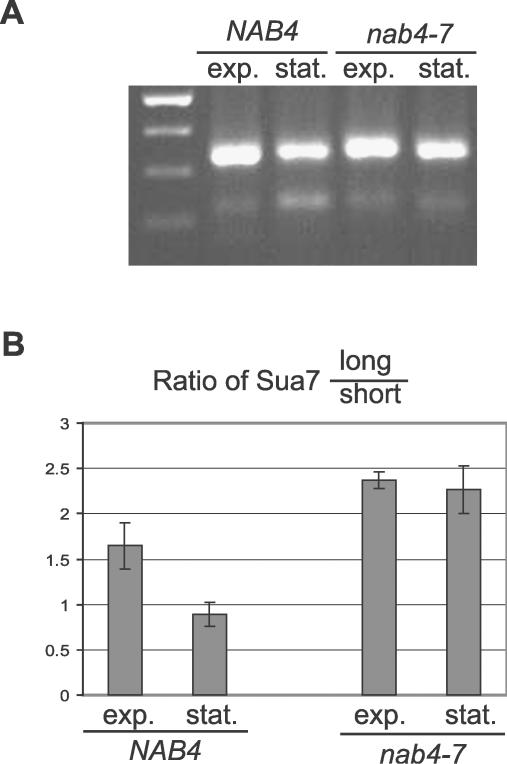

nab4-7 Displays Aberrant 3′ Cleavage Patterns for the SUA7 Transcript(A) 3′ RACE analysis of total RNA from NAB4 and nab4-7 strains in exponential and stationary phase. The SUA7 transcript has two isoforms, long and short. Lane 1 contains a 100-nucleotide molecular weight ladder with the 500-base pair marker located at the top of the gel. Lanes 2 and 3 display 3′RACE analysis of SUA7 from wild-type NAB4 strains; lanes 4 and 5 from mutant nab4-7 strains. For lanes 2 and 4, total RNA was harvested from exponential phase, lanes 3 and 5 harvested from stationary phase.(B) Quantitation of the ratio of long versus short form on the SUA7 transcript in NAB4 and nab4-7 strains in both exponential and stationary phase. This quantitation is based upon Northern analysis (unpublished data). Ratio reflects the average of three independent experiments. Error bars reflect the standard error of the mean.